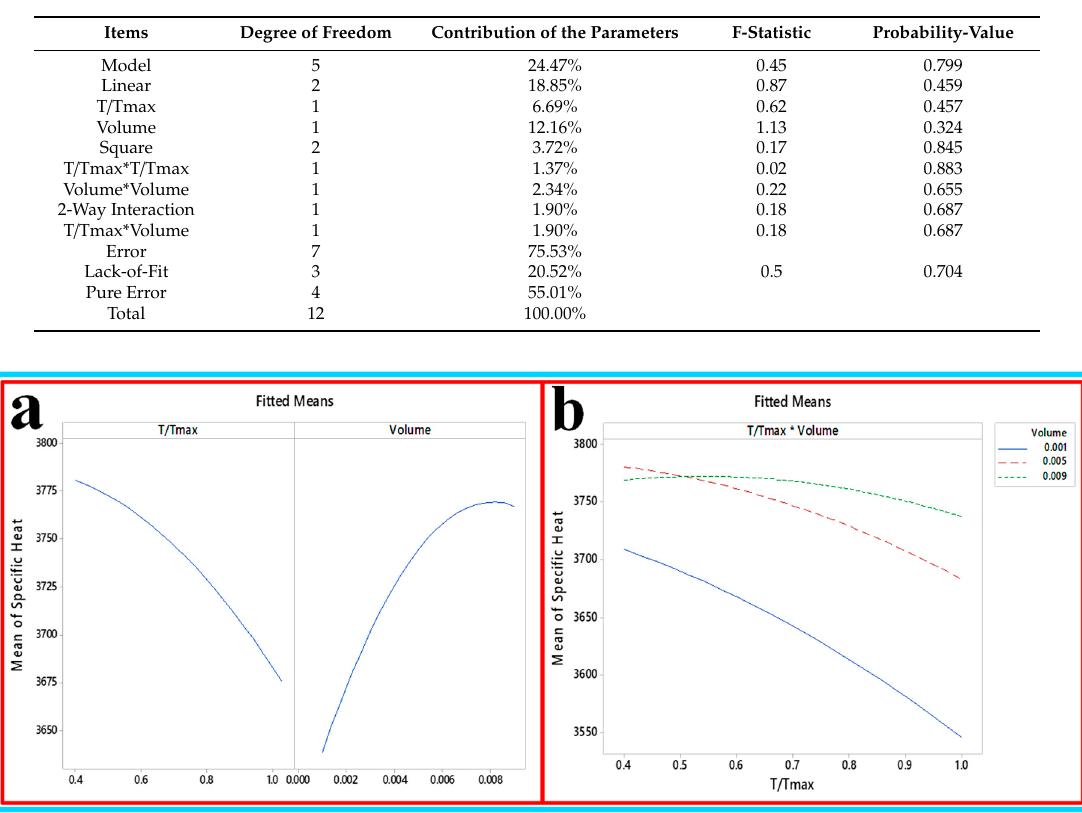
Figure 20. ( a ) Factorial plot and ( b ) interaction plot for specific heat.